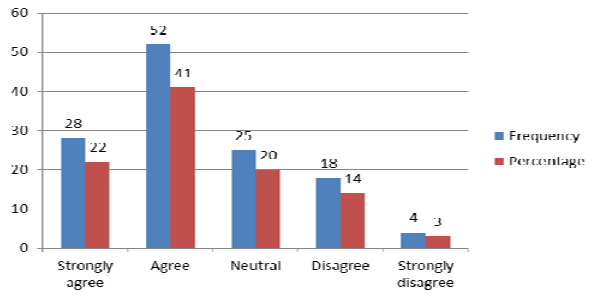
Fig. 5. Condition of